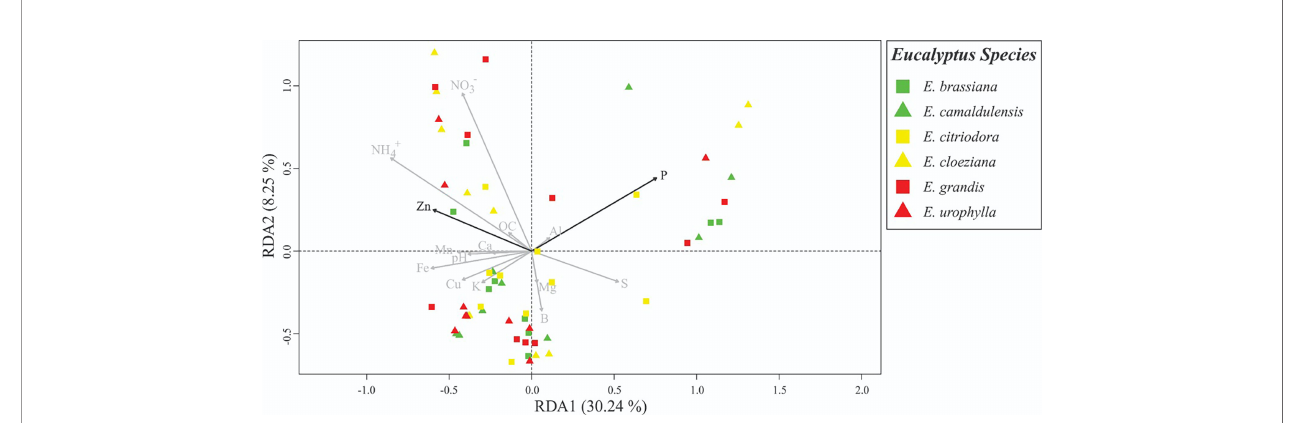
FIGURE 2 | Redundancy analysis (RDA) showing the correlations between AMF-groups and soil chemical properties. Black arrows indicate the signi fi cant attributes detected through forward